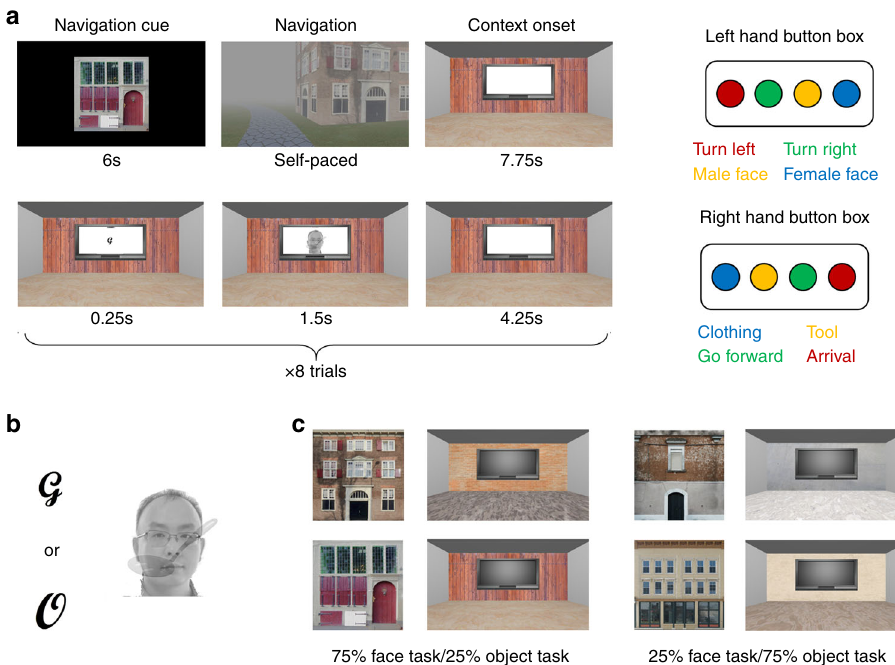
Fig. 2 Experimental design. a Experiment trial structure and response mappings. Left: structure of an exemplar block. Participants were fi rst cued to navigate to a target building and then entered a room in the building (top row). They then performed eight perceptual decision-making trials within the room (bottom row). Right: response mapping. Blue, yellow, green and red buttons correspond to index, middle, ring and pinky fi ngers, respectively. Participants were randomly assigned to use one hand to respond to faces and to use the other hand to respond to objects. b Task cues and an example stimulus pair. Depending on the letter/task cue (left), participants were to identify the gender of the face or the type of object in the compound stimulus (right). c Building exteriors and room interiors for the four contexts. For each participant, the mapping of the four contexts to the two CTDs was randomly